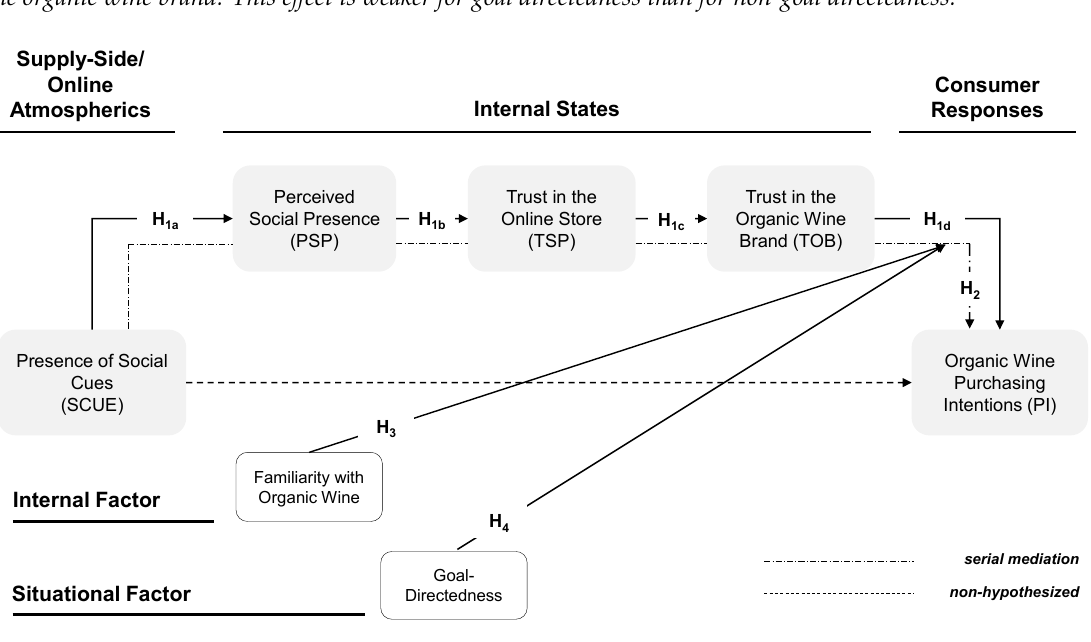
Figure 1. Conceptual model.